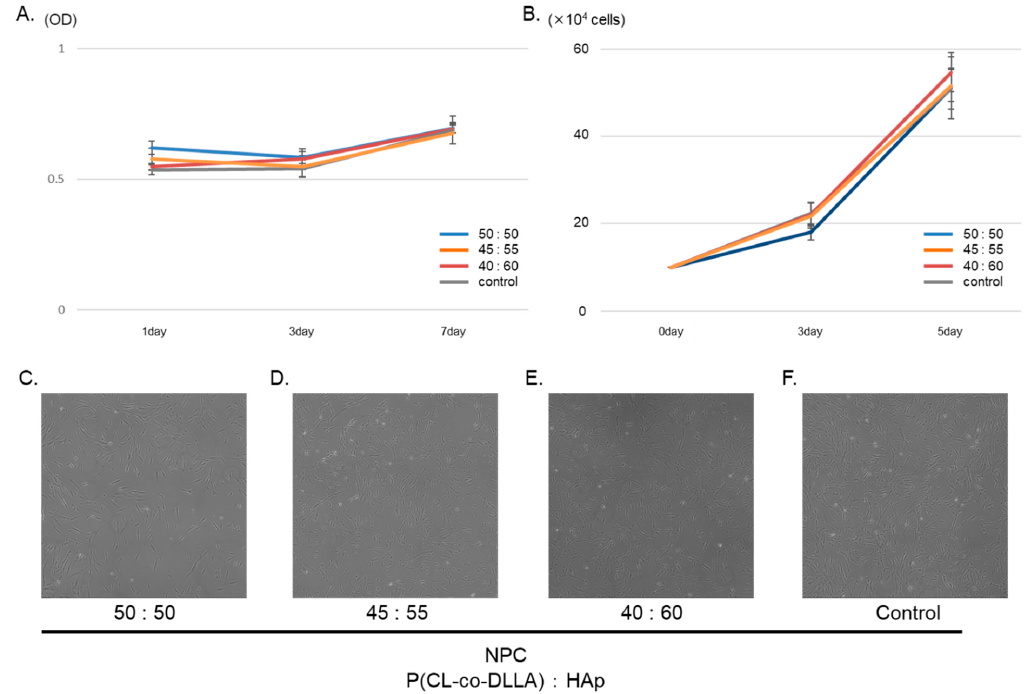
ff ect of NPC on hDPSC biocompatibility in vitro. The LDH assay was used to evaluate Figure 3. Effect of NPC on hDPSC biocompatibility in vitro . The LDH assay was used to evaluate cell Figure 3. E